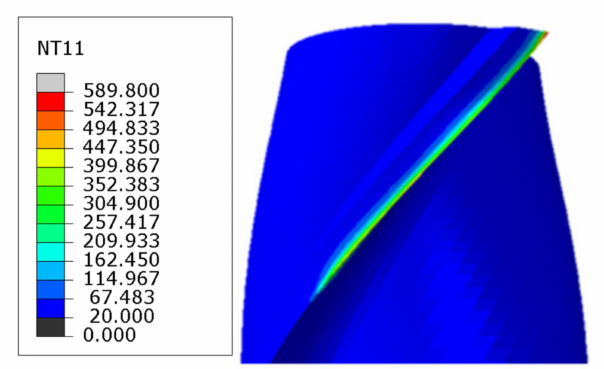
Figure 12. Temperature of the cutting edge after